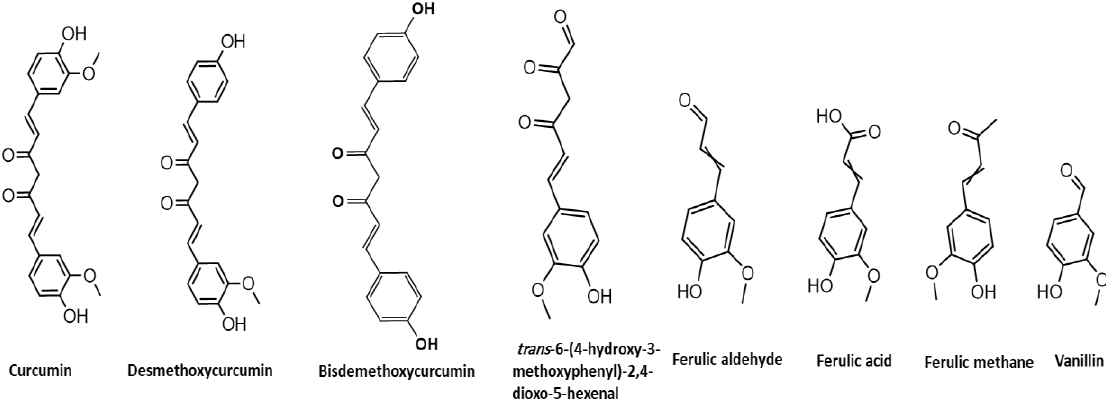
Figure 1. Chemical structure of curcuminoids, and their common degradants.